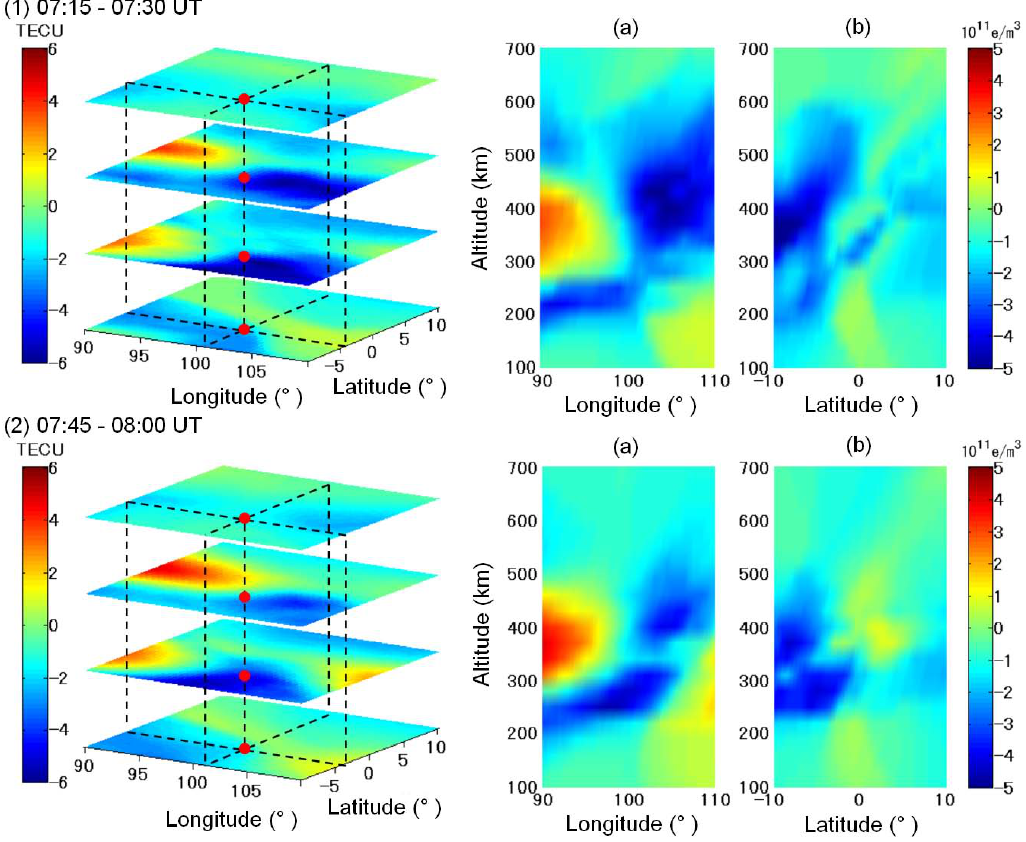
Fig. 13. Example of electron density distributions (1) 07:15–07:30UT, (2) 07:45–08:00UT. The red dots indicate the projection of the epicenter. Left panel indicates the IECs. (a) Longitudinal difference in electron density between the observed data and the reference data at the same latitude of epicenter (4.520 ◦ S). (b) Latitudinal difference in electron density between the observed data and the reference data at the same longitude of the epicenter (101.374 ◦